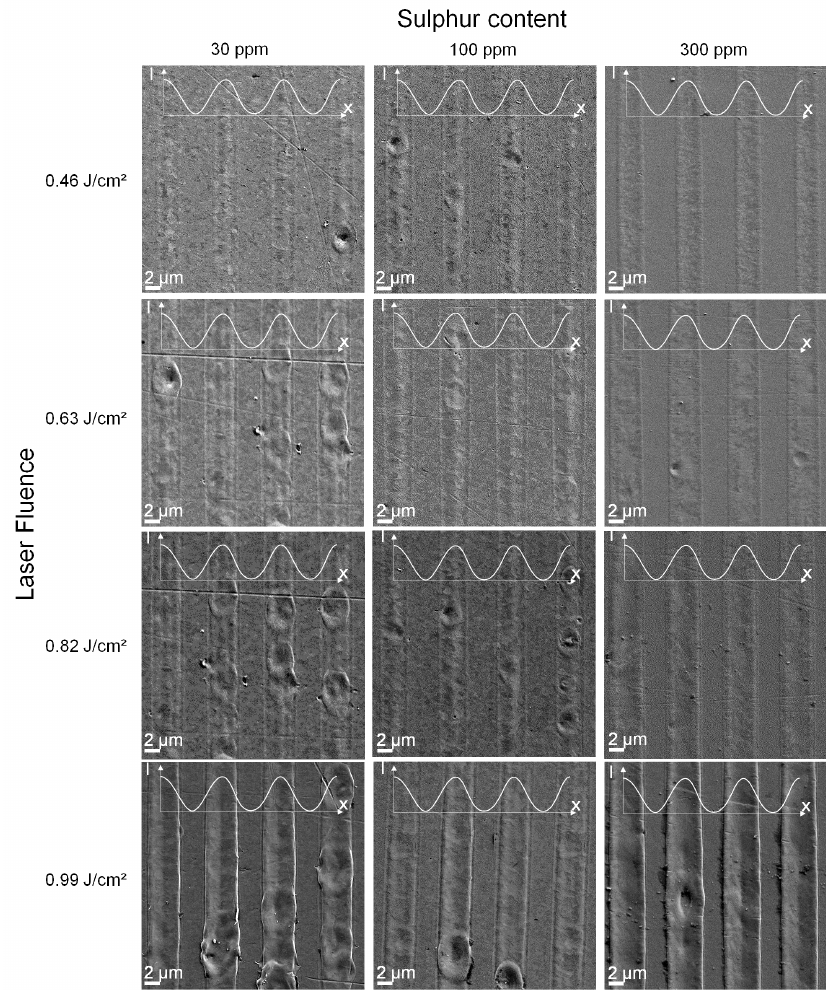
Figure 6. Scanning electron micrographs of surfaces after DLIP ( λ = 1053 nm, Λ = 7.2 µm, and τ p = 12 ns) on steel substrates with distinct sulphur contents using a single pulse and different laser fluences. Small graphs indicate areas of maximum laser intensity. The brightness and contrast of the SEM images were enhanced for better